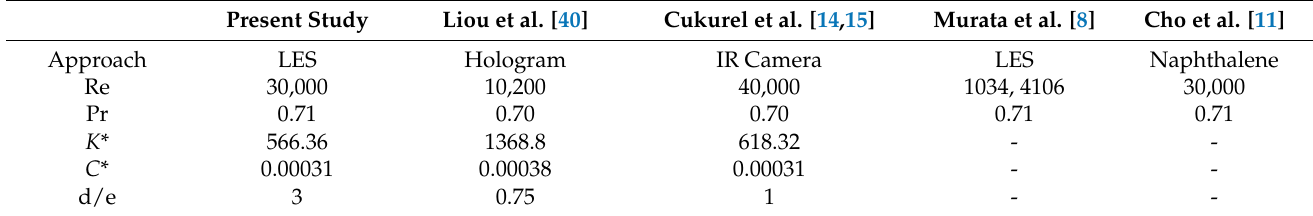
Table 1. Parameters of data compared with this study.